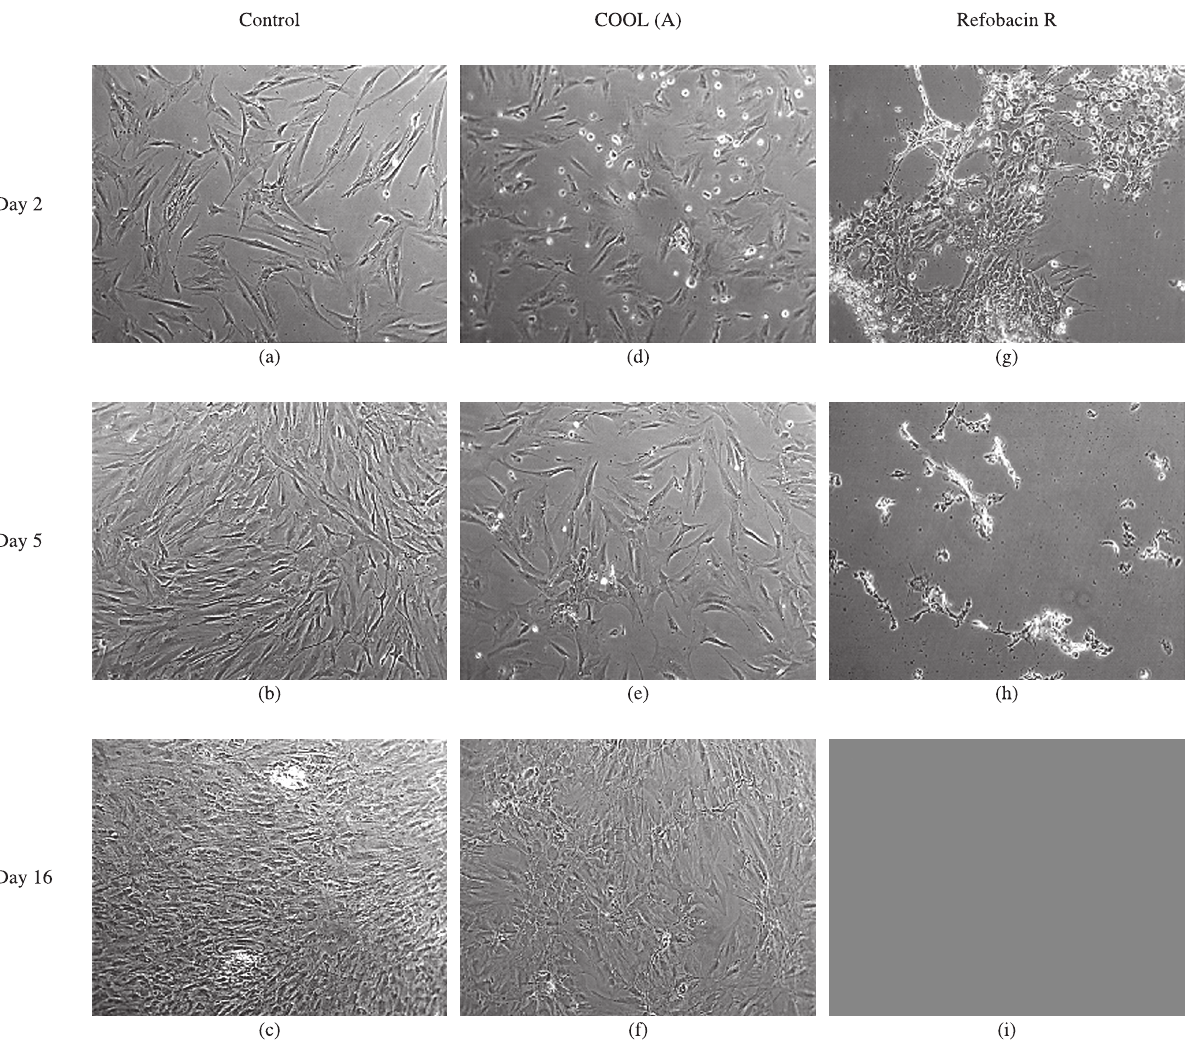
Figure 5. Light microscopic analysis of pHOB cell morphology (donor 1) during incubation with specimens of COOL formulation A (d-f) in comparison to cells of the control (a-c) and those with reference material (g-i) at day 2, 5 and 16 of culture. Bone cement specimens were added to the cell cultures imme- diately after preparation (magnification